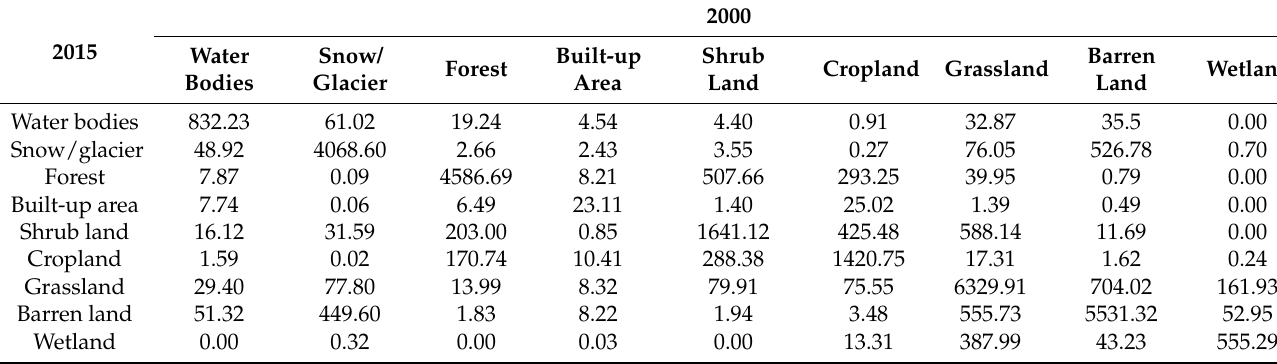
Table 4. Transition matrix of different LULC types in the KSL during the period 2000–2015.